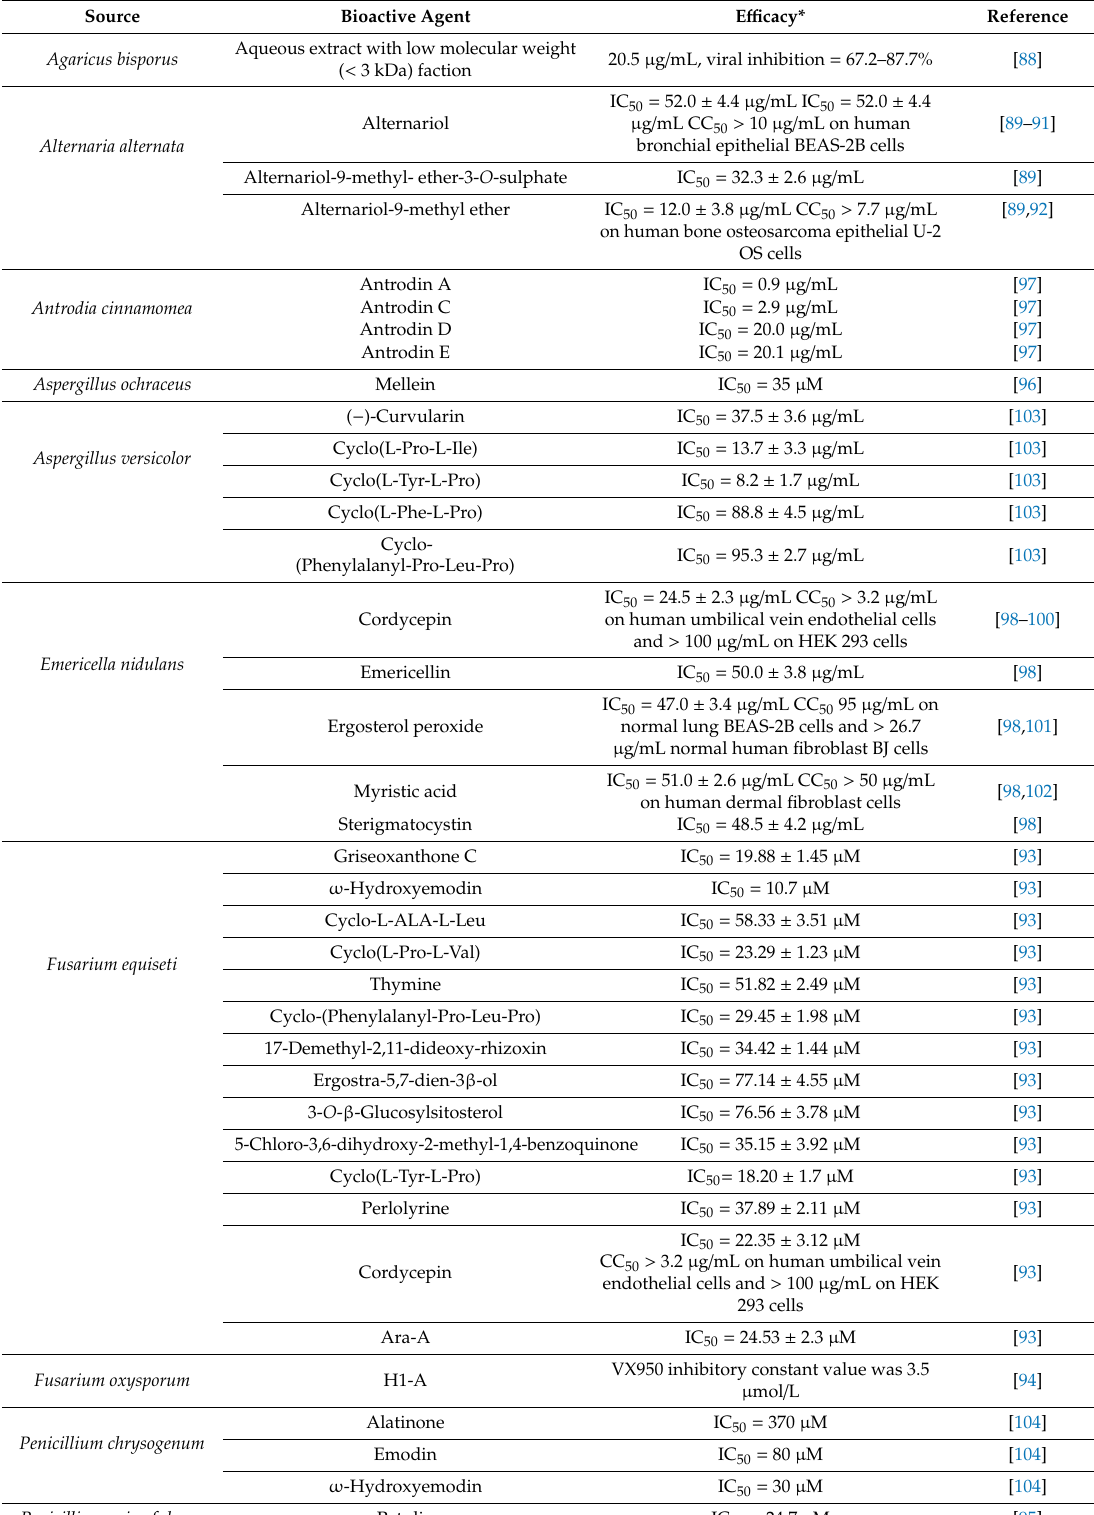
Table 2. Fungal bioactive compounds for HCV NS3 / 4A protease inhibitor as potential candidates for the treatment of CoVs, particularly